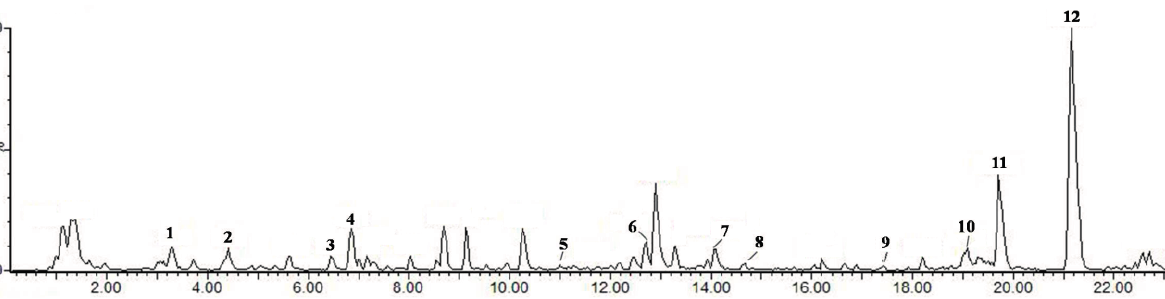
Figure 6. HPLC-MS chromatograms of MTF.